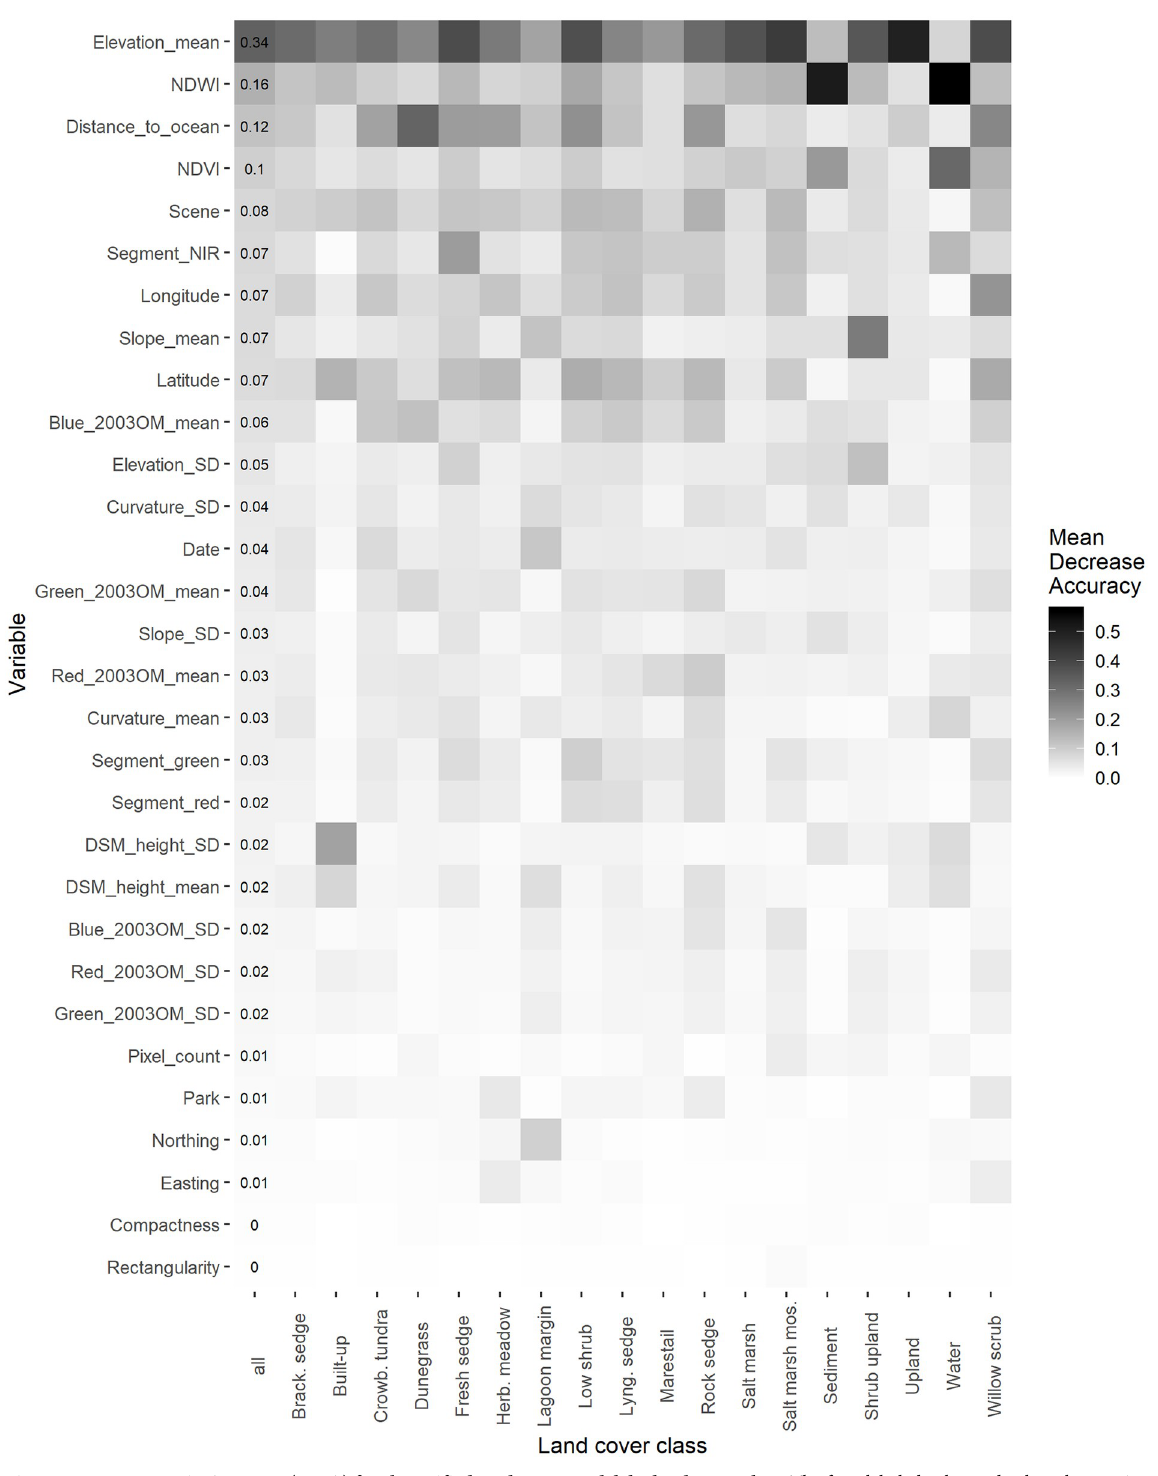
Fig 5. Mean Decrease in Accuracy (MDA) for the unified study area model, by land cover class. The first, labeled column displays the MDA for the model overall.